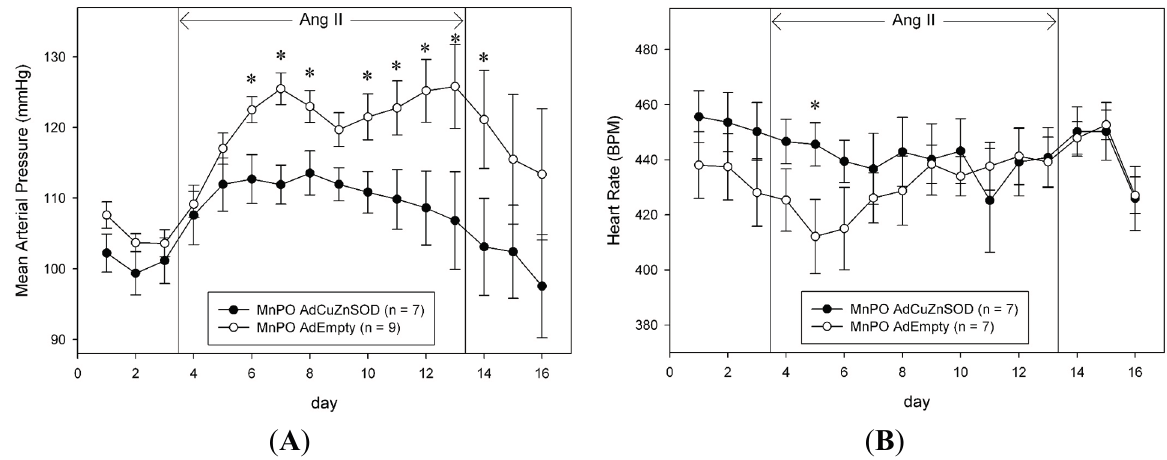
Figure 2. Average 24-h mean arterial pressure ( A ) and heart rate ( B ) recorded during saline infusion (3 days of control and recovery period) and 10 days of AngII infusion (10 ng/kg/min) in rats that were MnPO injected with adenoviral vectors encoding human CuZnSOD (AdCuZnSOD) or control vector (AdEmpty). * p < 0.05 vs. AdEmpty-injected rats.